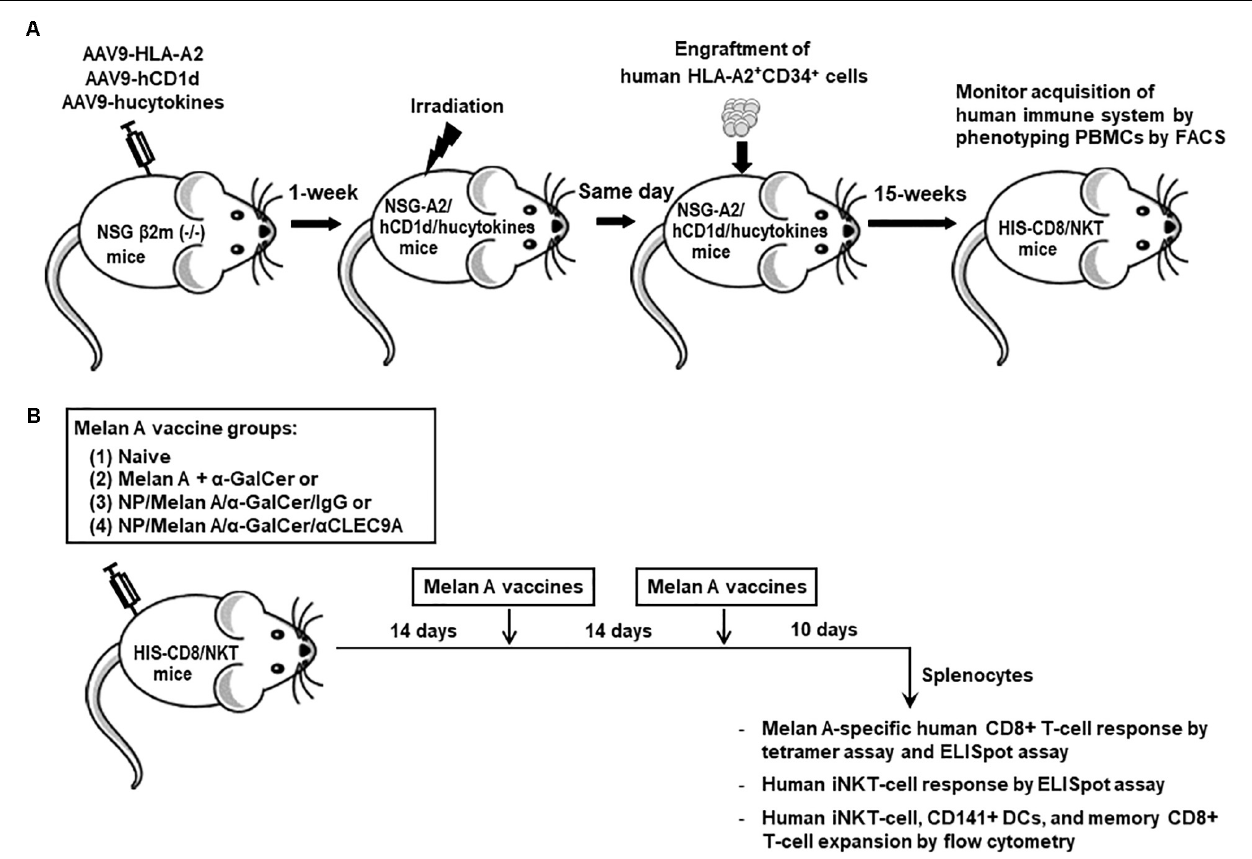
FIGURE 1 | Establishment of HIS-CD8/NKT mice and schematic representation of the immunization protocol. (A) NSG-B2m mice were first transduced with HLA-A2, human CD1d, and selected human cytokines, followed by sub-lethal irradiation and engraftment of HLA-A2 + HSCs after 1 week. Fifteen weeks after the HSC engraftment, the status of HIS reconstitution was determined by measuring the percentages of certain human lymphocyte subpopulations present in PBMCs by flow cytometry. (B) After the establishment of HIS-CD8/NKT mice, they were immunized with NP-based Melan-A vaccines three times with 2-week intervals and 10 days after the last boost, splenocytes were isolated and various immunoassays were